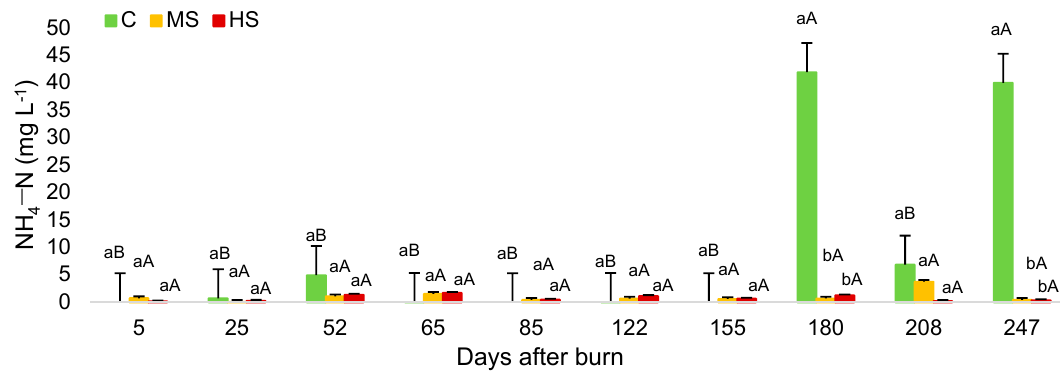
Figure 5. Treatment effect under control (C), moderate severity (MS), and high severity (HS) burn on ammonium (NH 4— N) (mg L − 1 ) concentration between 5 and 247 days after pile burning. Mean values followed by the different lowercase letters show significant differences within the same date. Mean values followed by the different uppercase letters show statistically significant differences within the same treatment. Significant differences were observed at p < 0.05 . Hanging bars represent the standard error. ( n = 5).